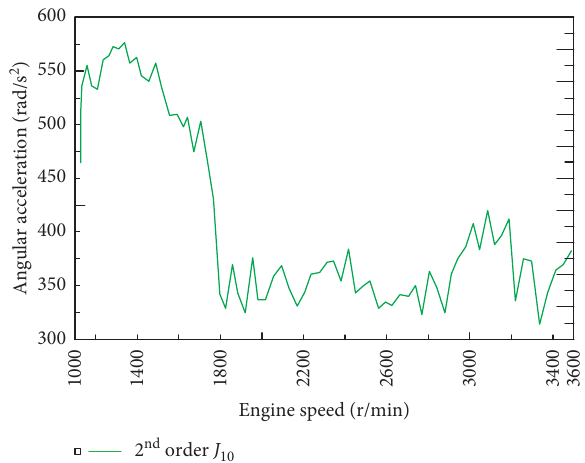
Figure 39: The 2 nd order angular acceleration curve of the input shaft of the gearbox matching the DMF under driving conditions.